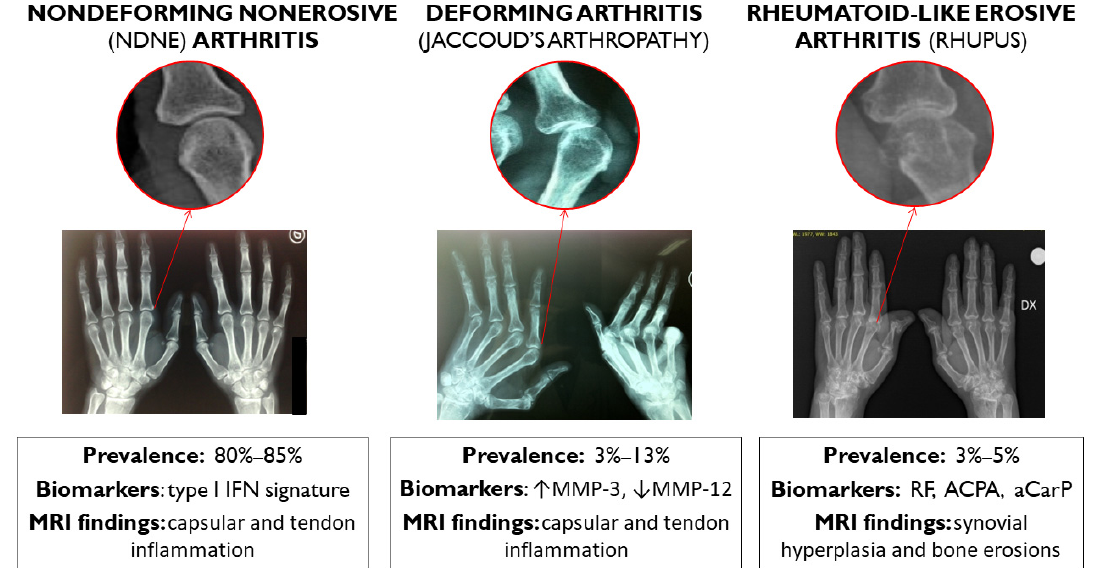
Figure 1. According to clinical findings and traditional X-ray, SLE arthritis can be classified into three different subtypes with different prevalences, biomarkers, and MRI findings: nondeforming nonerosive (NDNE) arthritis; radiologically nonerosive but deforming arthropathy, namely, Jaccoud’s arthropathy; and rheumatoid-like erosive arthritis. IFN: interferon. MMP: matrix metalloproteinase. RF: rheumatoid factor. ACPA: anticyclic citrullinated peptide antibodies. aCarP: anticarbamylated proteins.